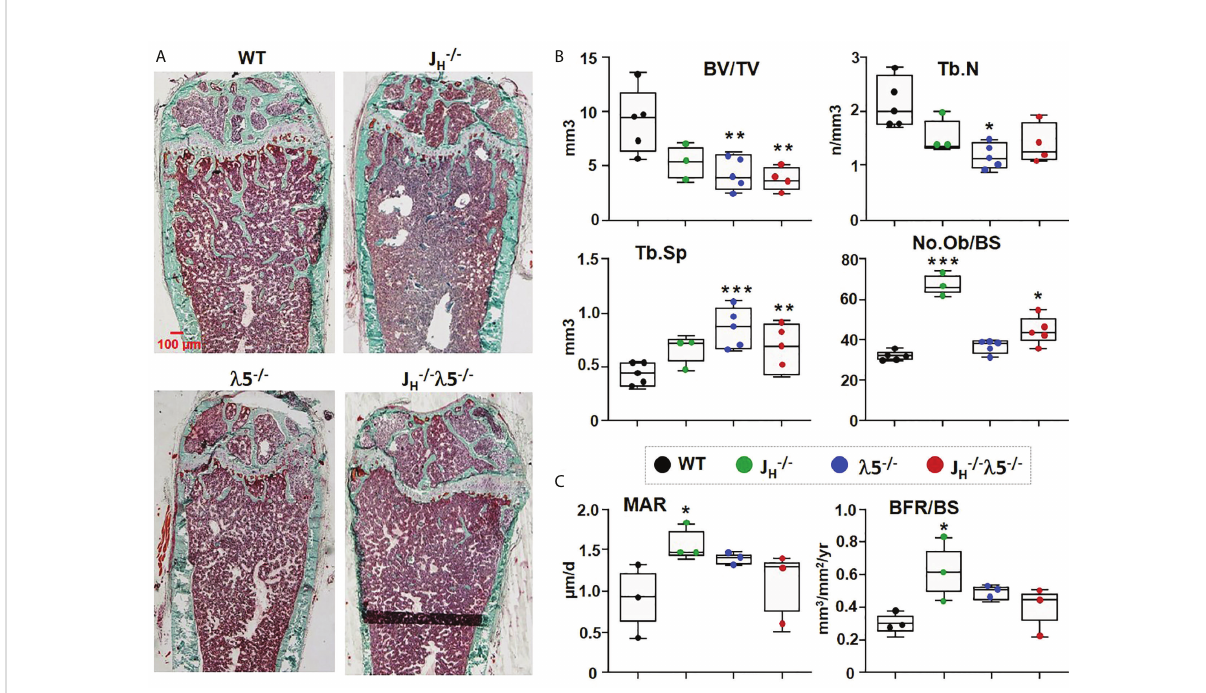
FIGURE 2 Osteoblast numbers and bone synthesis are increased in B cell-de fi cient mice. (A) Undecalci fi ed femurs from 6 ‐ month ‐ old females were embedded in plastic, sectioned laterally, and stained with Masson ’ s trichrome. Representative images are shown at 2X magni fi cation. (B) Average histomorphometric values pooled from n=3-5 mice per group. Bone parameters shown are trabecular BV/TV ratio, Tb.N=trabecular number, Tb.Sp=trabecular space, and No.Ob/BS= osteoblast number per bone surface. (C) Dynamic histomorphometry was performed on calcein ‐ labeled bones. Average mineral apposition rate (MAR) and bone formation rate (BFR/BS) are shown. Statistical signi fi cance relative to WT mice was calculated by ANOVA. *p<0.05, **p<0.01, ***p<0.001. Scale bar: